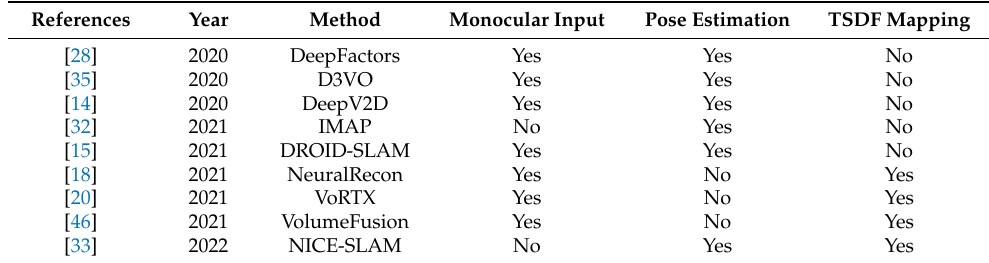
Table 1. Comparison of existing learning-based approaches.